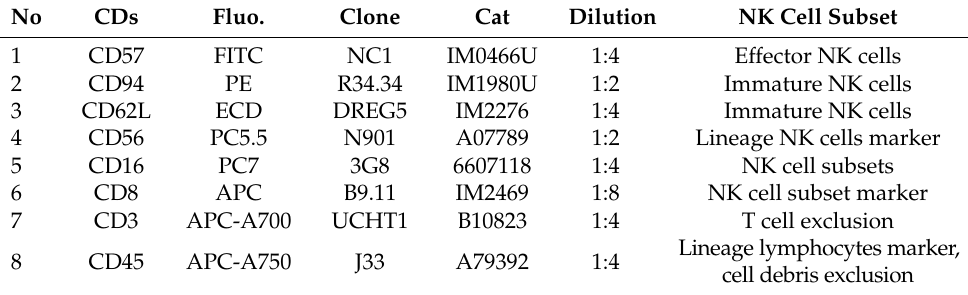
Table 8. Maim characteristics of antibodies used for flow